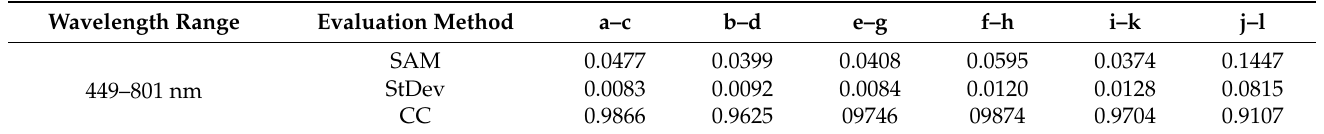
Table 3. Comparison of Spectral Similarity in Visible Light Band.